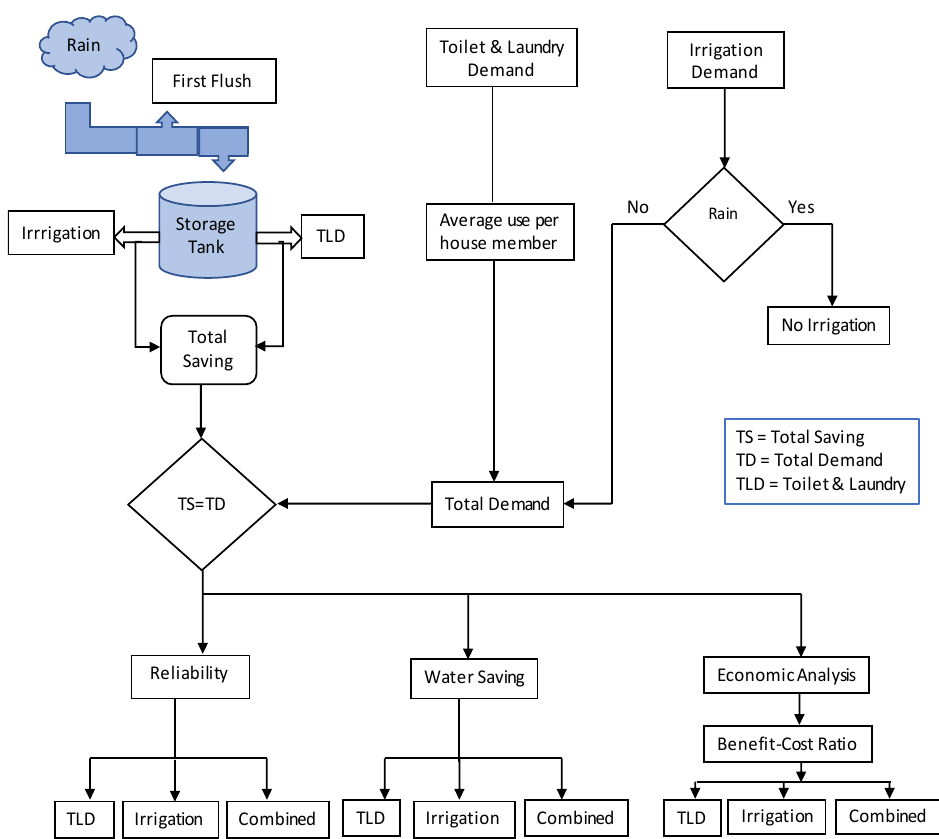
Figure 2. Flowchart showing the adopted methodology of daily water balance model.